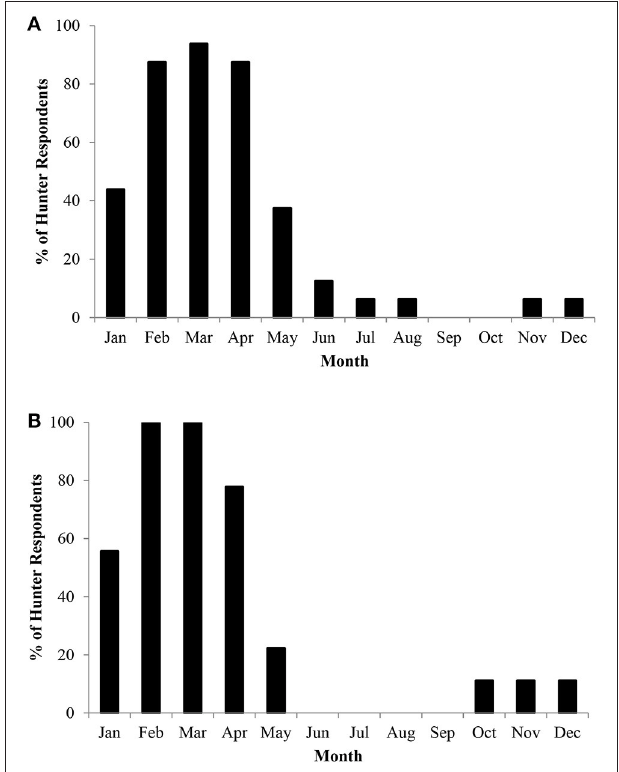
FIGURE 2 | (A,B) Distribution of months selected by (A) Tasiilaq hunters ( n = 16) and (B) Ittoqqortoormiit hunters ( n = 9) in response to “When is the best time to hunt polar bears